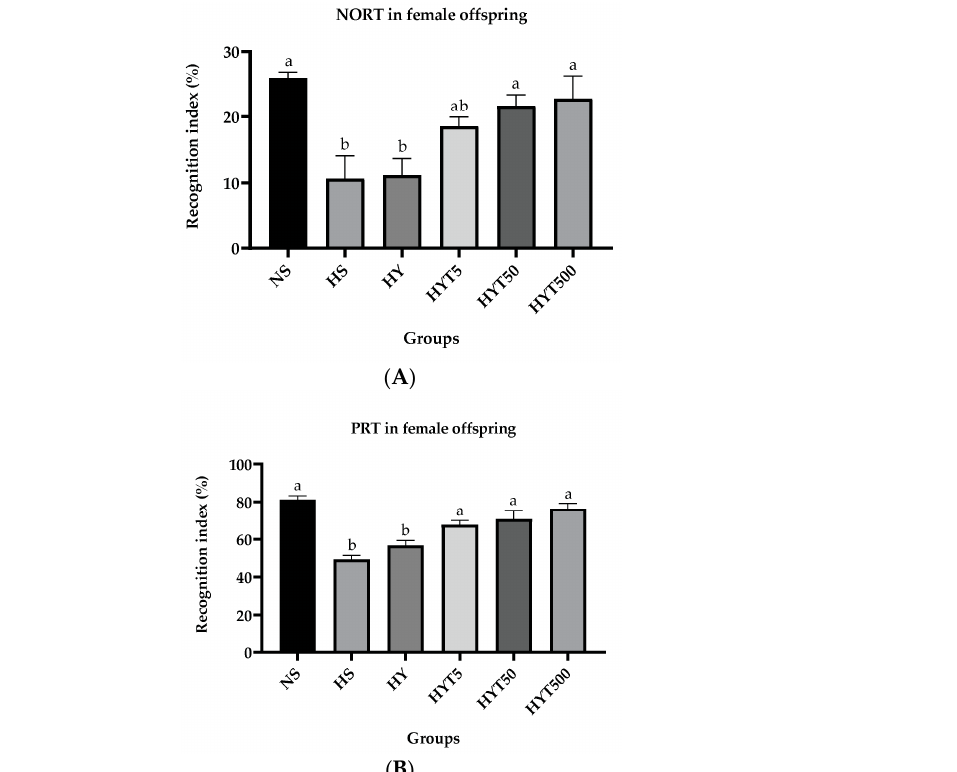
Figure 4. ( A ). Recognition index (%) of female offspring in NORT on PND 21. ( B ). Recognition index (%) of female offspring in PRT on PND 21. NS: normal chow and saline; HS: HFD and saline; HY: HFD and yoghurt; HYT5: HFD and 5 mg/kg of E. tapos yoghurt; HYT50: HFD and 50 mg/kg of E. tapos yoghurt; HYT500: HFD and 500 mg/kg of E. tapos yoghurt. Values are expressed as mean ± SEM. Different letters indicate a significant difference at p < 0.05.